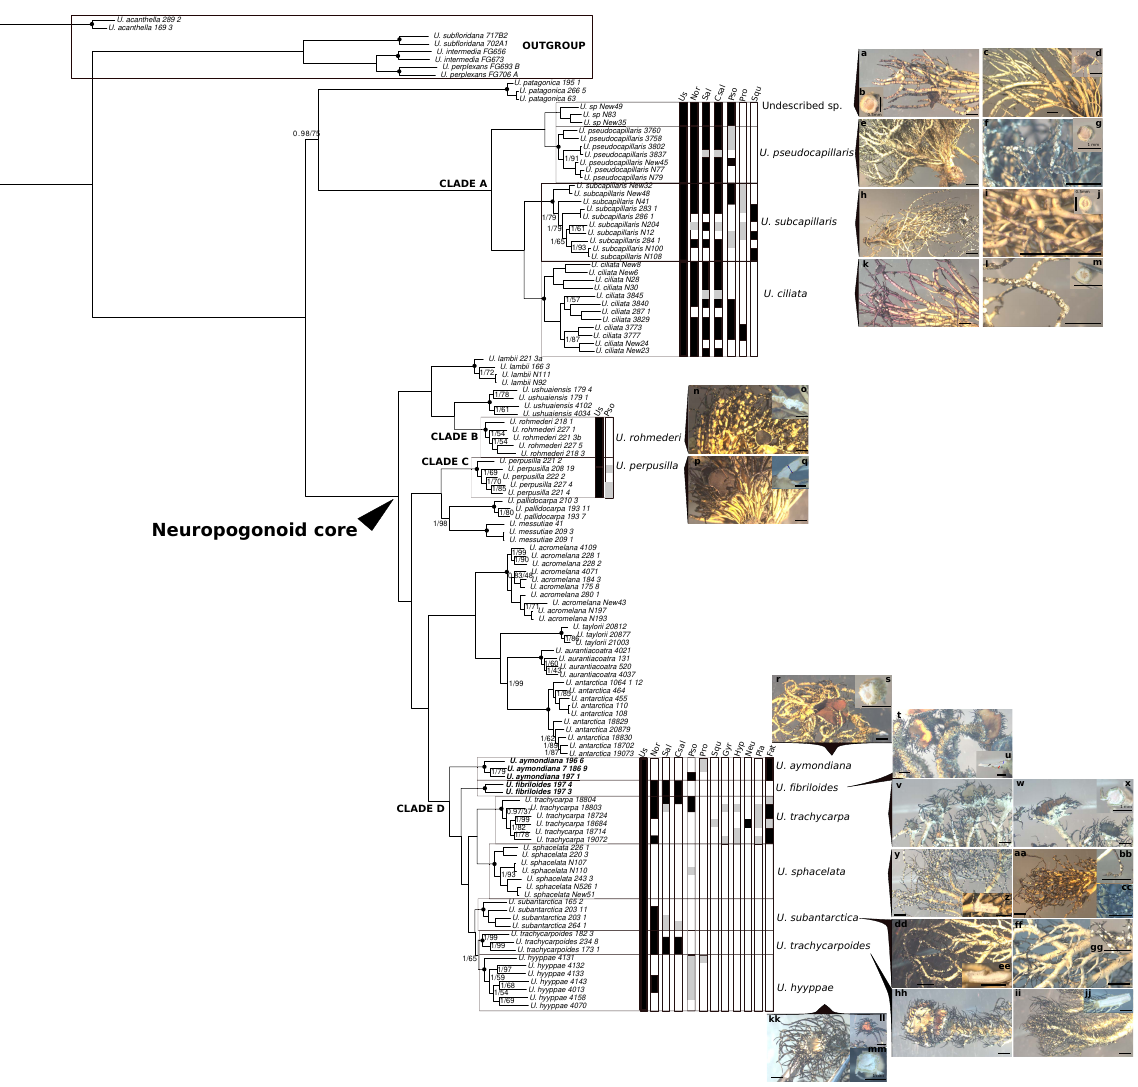
Figure 1. Phylogenetic reconstruction of neuropogonoid lichens based on concatenated DNA se- quences of 21,831 loci (m4 dataset) obtained from Bayesian inference (BI) through the ExaBayes software. Values at nodes indicate posterior probability yielded by BI on the left and bootstrap sup- port (BS) from maximum-likelihood (ML) inference (RaxML-NG software) on the right. Maximum support for both inferences (i.e., BI = 1; BS = 100) was obtained for those nodes with no values. Dark circles on the nodes represent the crown of the monophyletic species considered. Clades of taxonomic interest are marked with letters A-D. Chemical characters are shown for clades A-D. Up to 12 chemical acids were found: Us, Usnic acid; Nor, norstictic acid; Sal, salazinic acid; Csal, consalazinic acid; Pso, psoromic acid; Pro, protocetraric acid; Squ, squamatic acid; Gyr, gyrophoric acid; Hyp, hypostrepsilic acid; Neu, neuropogolic acid; Pla, placodolic acid; Fat, fatty acids. High concentration of the substance is indicated with black bands, low concentration or traces are indicated in gray bands, and non-colored bands indicate the absence of the substance. Images of the thallus, reproductive structures and inter- nal structure are shown for representative samples from each species at Clades A-D: ( a ) U. sp New49; ( b ) U. sp New35, thallus cross section; ( c ) U. sp New35, basis; ( d ) U. sp New35, apothecia; ( e ) U. pseu- docapillaris 3760; ( f ) U. pseudocapillaris 3758, soredia; ( g ) U. pseudocapillaris 3760, thallus cross section; ( h ) U. subcapillaris New 32; ( i ) U. subcapillaris N100; ( j ) U. subcapillaris New 32, thallus cross section; ( k ) U. ciliata New 23, ( l ) U. ciliata New 6; ( m ) U. ciliata N27, thallus cross section; ( n ) U. rohmederi 221-3B; ( o ) U. rohmederi 218-1, thallus longitudinal section; ( p ) U. perpusilla 222-2; ( q ) U.